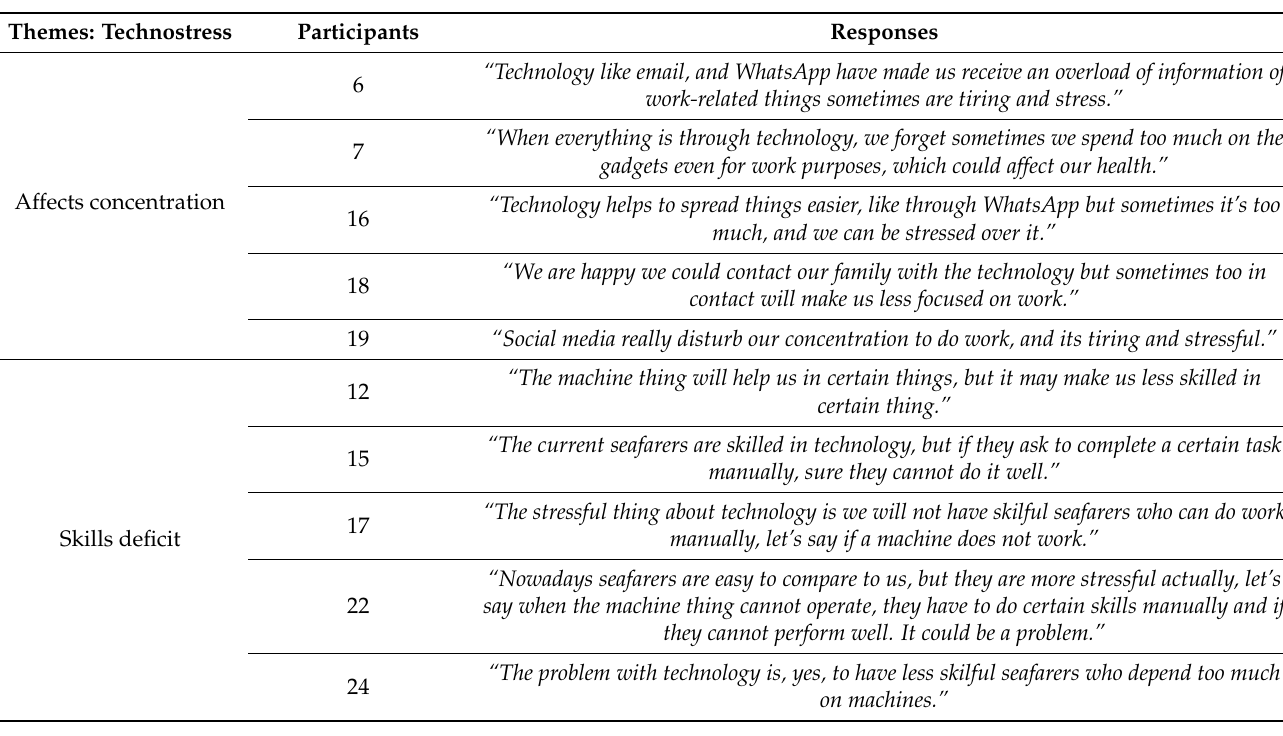
Table 7. Theme of technostress.